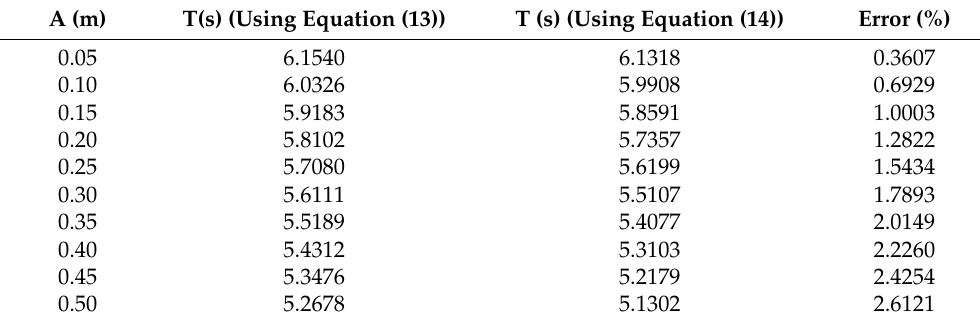
Table 2. Accurate and approximate solutions for oscillators with a quadratic restoring force